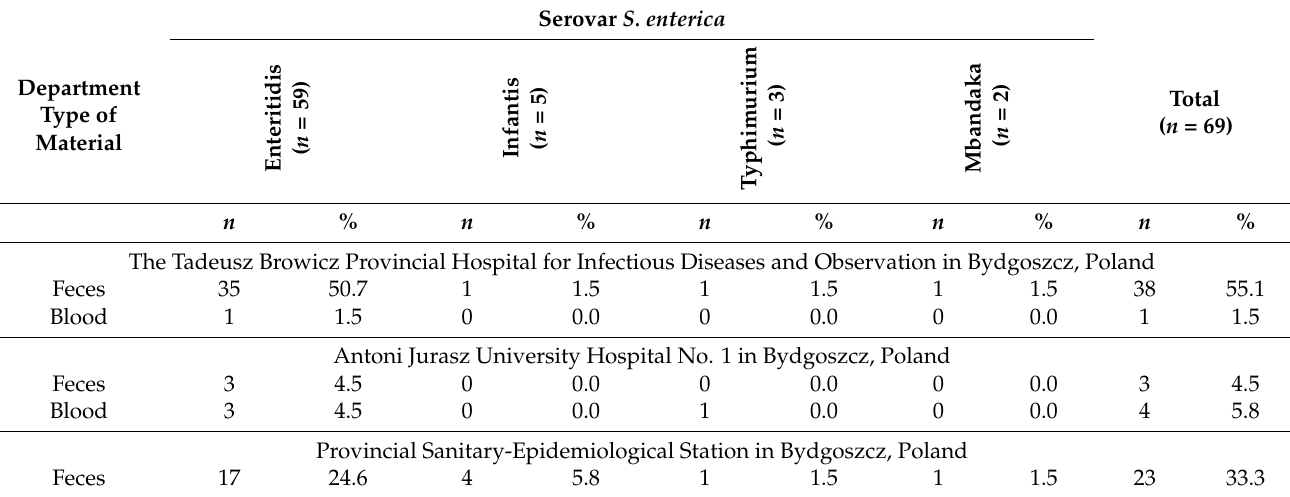
Table 1. The origin of tested S. enterica strains ( n =